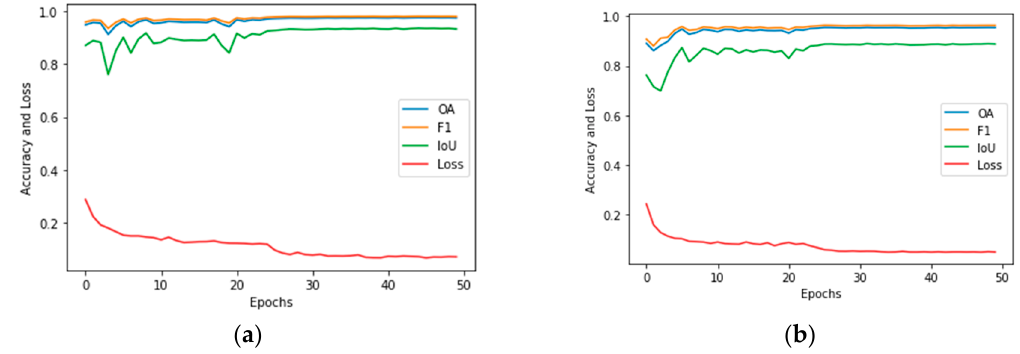
Figure 5. Plots showing the accuracy (including OA, F1 score, and IoU) and loss of the proposed MAFNet for training the Potsdam dataset ( a ) and Vaihingen dataset ( b ). Table 2. Statistical results on the validation set with different learning rates.